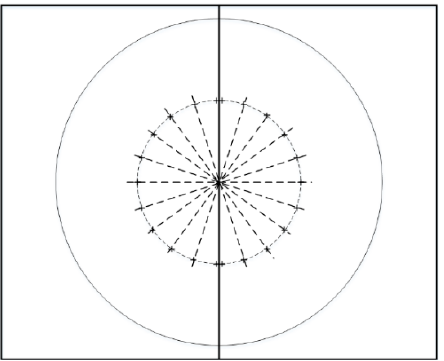
Figure 10. Axial view of temperature sensor locations inside the housing.